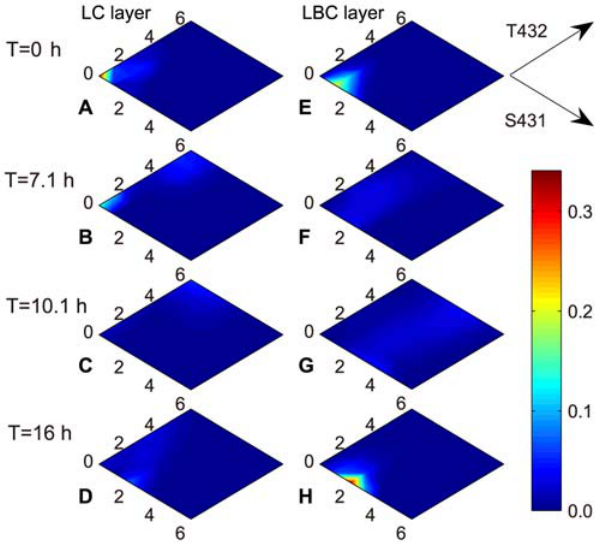
Figure 4. Snapshots of node-to-node mass evolution in the network. Panels A–D show the snapshots for LC layer, and panels E–H for LBC layer. The time for minimum Y is set to be the zero circadian time. Three other time points are chosen for comparison: T=7.1 h (at phosphorylation phase), T=10.1 h (the peak time) and T=16 h (at dephosphorylation phase). The color bar shown on right corresponds to the fractions of all nodes in the contour map.